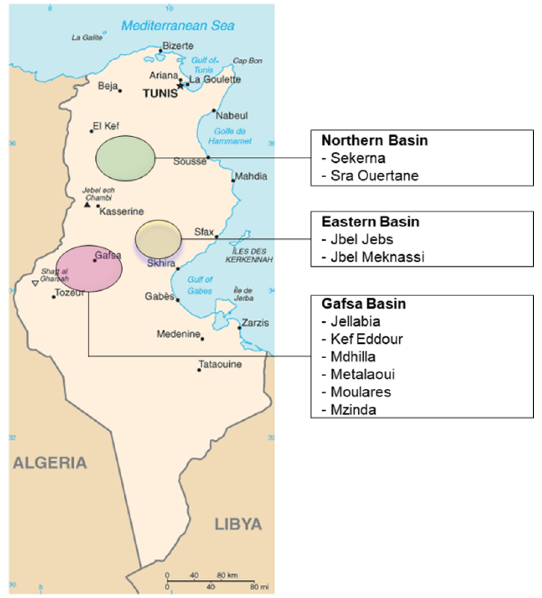
Figure 1. Major phosphate rock deposits in Tunisia.